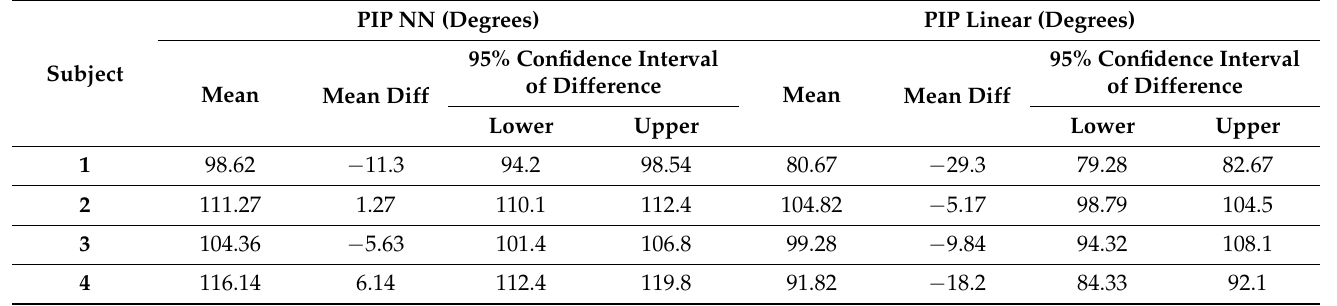
Table 7. Average NN and linear comparisons for PIP